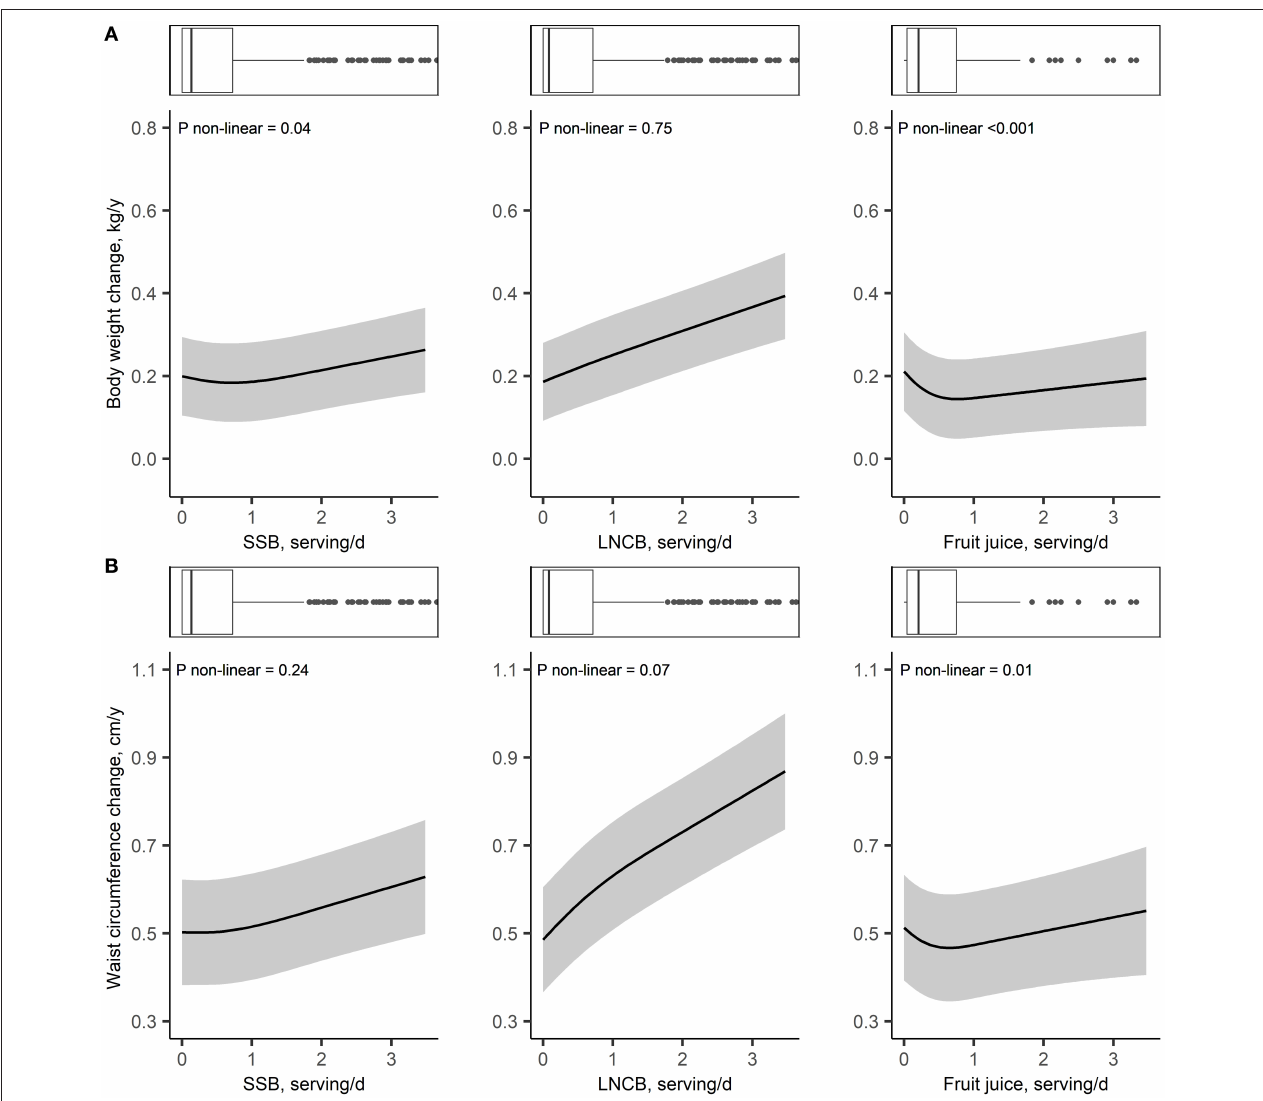
FIGURE 1 | Adjusted dose-response associations of SSB, LNCB, and fruit juice consumption with body weight change (kg/year) (A) and waist circumference change (cm/year) (B) in the Lifelines Cohorts Study; Models were adjusted for age, sex, height, baseline weight or baseline waist circumference (for models with waist circumference as outcome), education, alcohol intake, smoking, physical activity, all dietary factors, total energy intake and history of diseases. SSB, sugar-sweetened beverages; LNCB, low/no-calorie beverages.